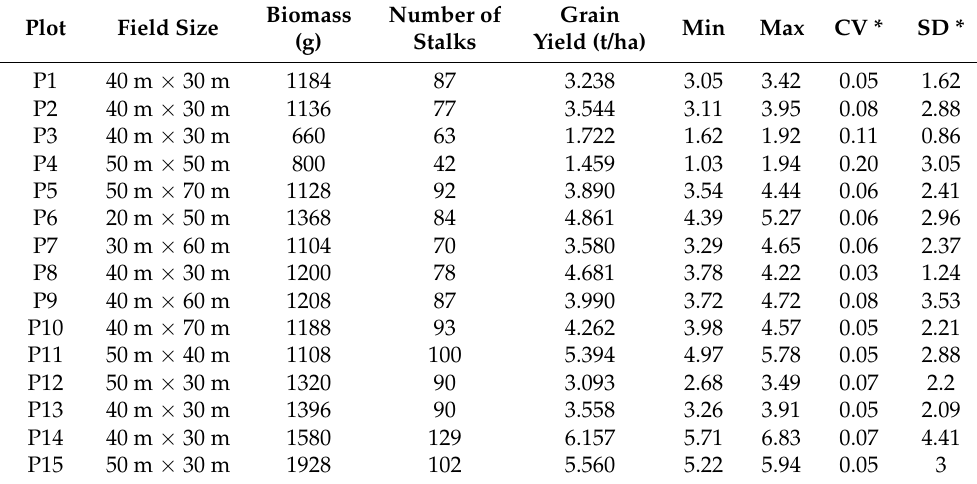
Table 3. Summary of the plots